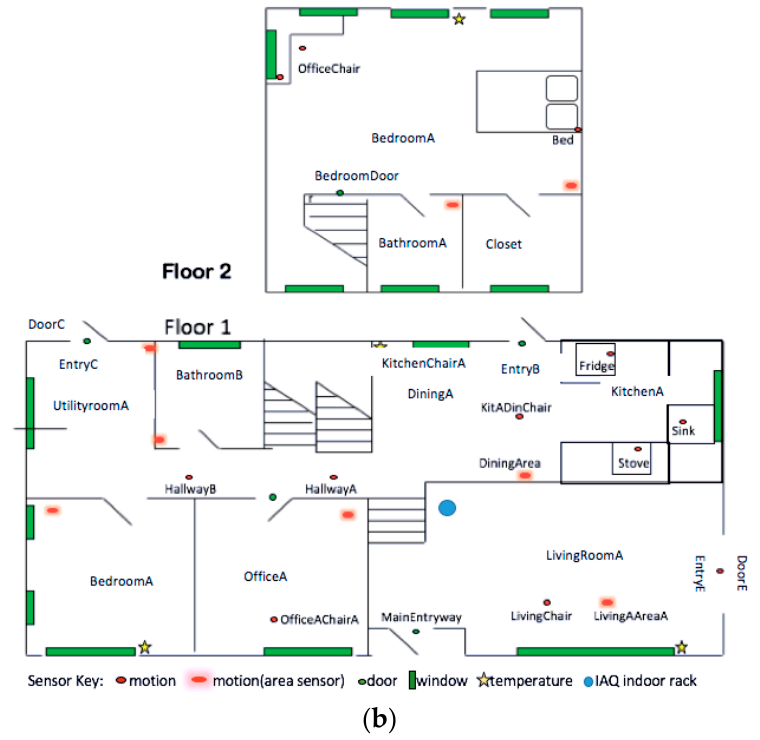
Figure 1. The floorplans and sensor layouts for the two smart homes. ( a ) The layout for IAQ 1 ; ( b ) The layout for IAQ 2 .